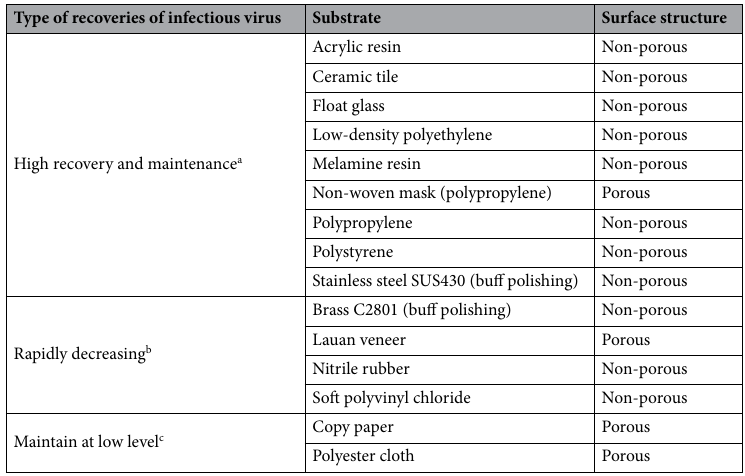
Table 3. Types of trend in recovery of infectious virus on substrates tested. a The recovery of infectious virus from the surface at 0 h after drying of the viral inoculum was not strongly decreased, and the recovery of infectious virus from the surface was maintained for a relatively long term. b The recovery of infectious virus from the surface at 0 h after drying of the viral inoculum was not strongly decreased, however, the infectious virus immediately died. Alternatively, the recovery of infectious virus from the surface at 0 h after drying of the viral inoculum was strongly decreased, and the infectious virus immediately died. c Although the recovery of infectious virus was strongly decreased at 0 h after drying of the viral inoculum, it was maintained for a very long time at a low